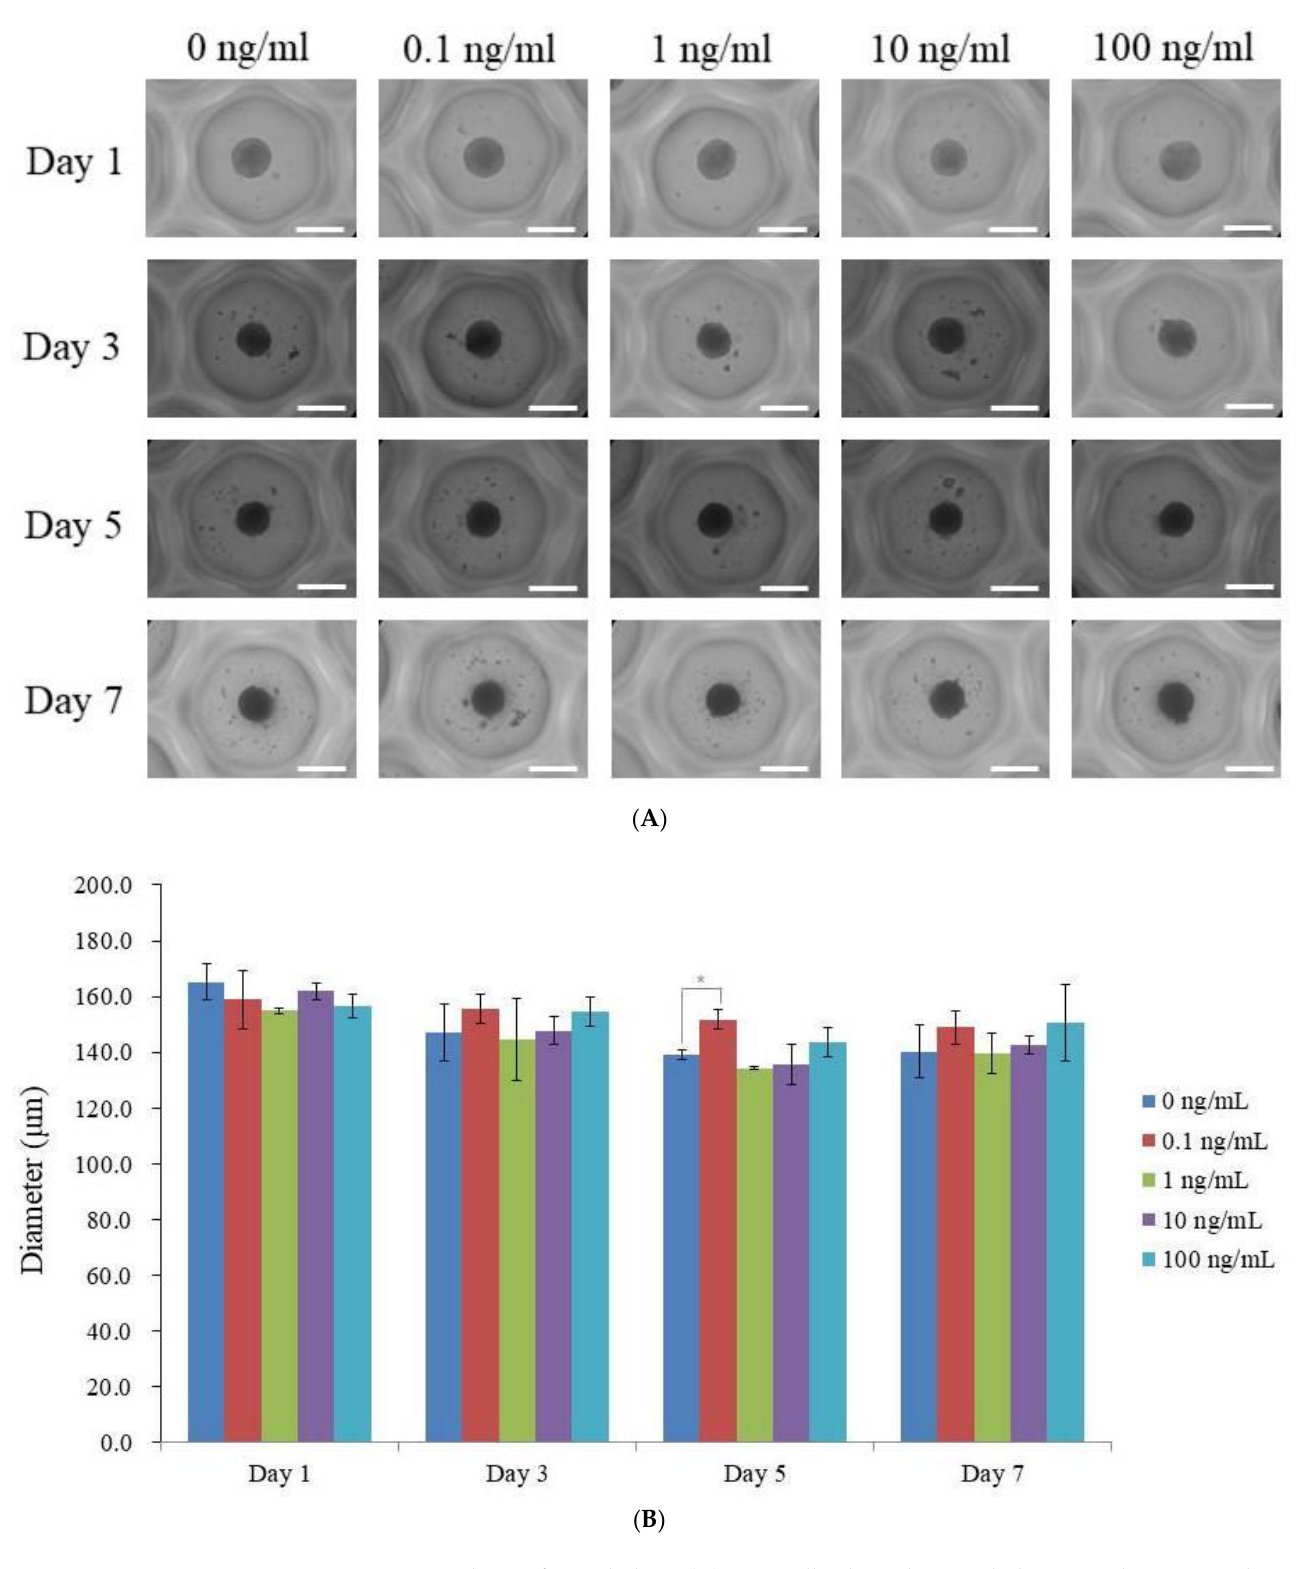
Figure 1. Analyses of morphology. ( A ) Stem cell spheroids ’ morphologies on days 1, 3, and 5 and 7 after being exposed to different vitamin E concentrations. A total of 200 μ m (with an original magnification of 200) is indicated by the scale bar. ( B ) The stem cell spheroids ’ diameters on days 1, 3, 5, and 7. * Day 5 time-matched comparison with the 0 ng/mL group: p < 0.05.